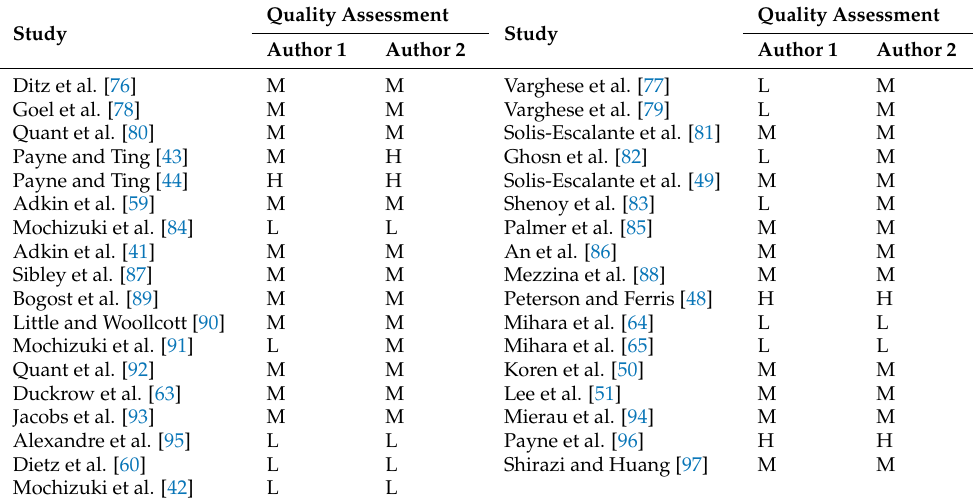
Table 1. Quality Assessment of Included